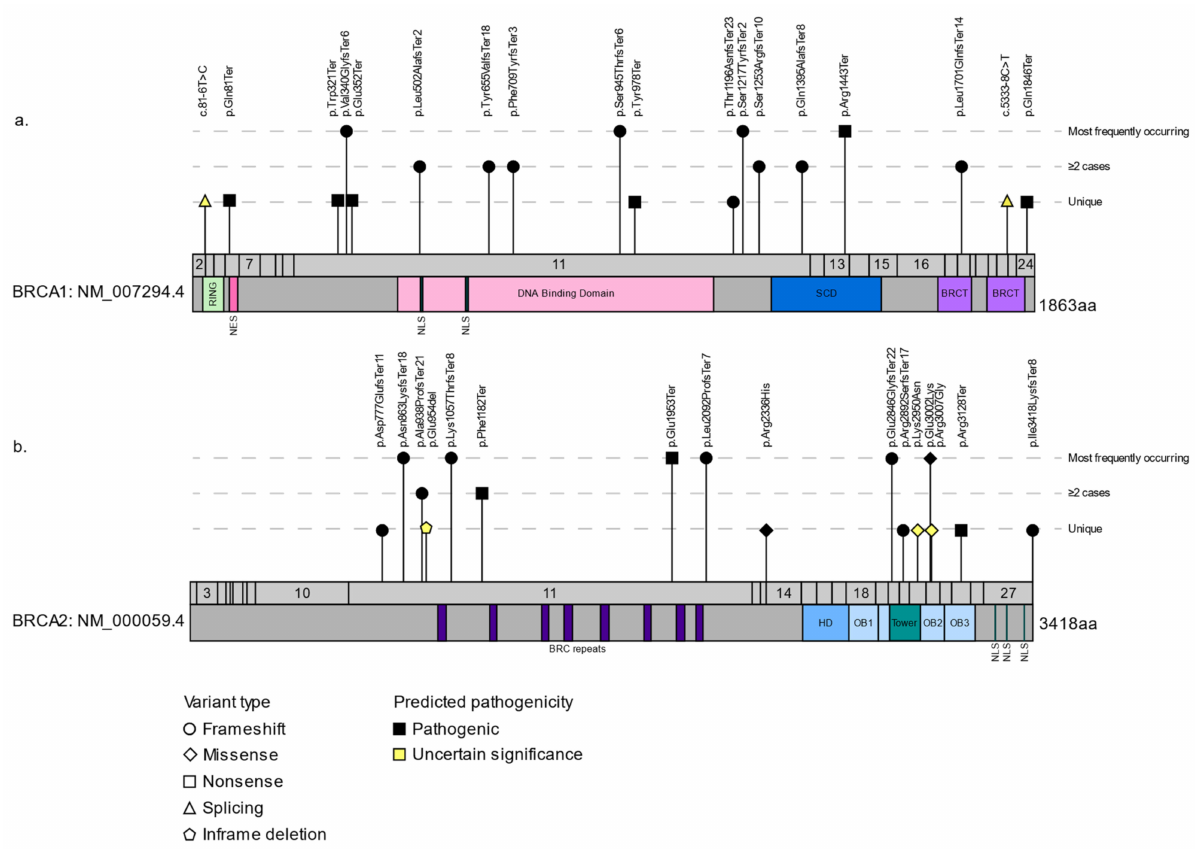
Figure 3. Pathogenic variants and variants of uncertain significance reported in French Canadians of Quebec mapped to full length BRCA1 ( a ) or BRCA2 ( b ) transcripts. Variants are predicted to be pathogenic or have uncertain significance based on ClinVar and/or ACMG guidelines. RING = Really Interesting New Gene domain; NES = Nuclear export signal; NLS = Nuclear localization signal ( BRCA1 : [92]; BRCA2 : [93]); SCD = Serine cluster domain [94]; BRCT = BRCA1 C Terminus domain; BRC repeats = BRCA2 repeats; HD = Helical domain; OB = Oligonucleotide binding; Tower = Domain essential for DNA binding [95]. BRCA1 GenBank: AAC37594.1 [96], BRCA2 GenBank: AAB07223.1 [97], DNA binding domain [98]. See Table S2 for more information about